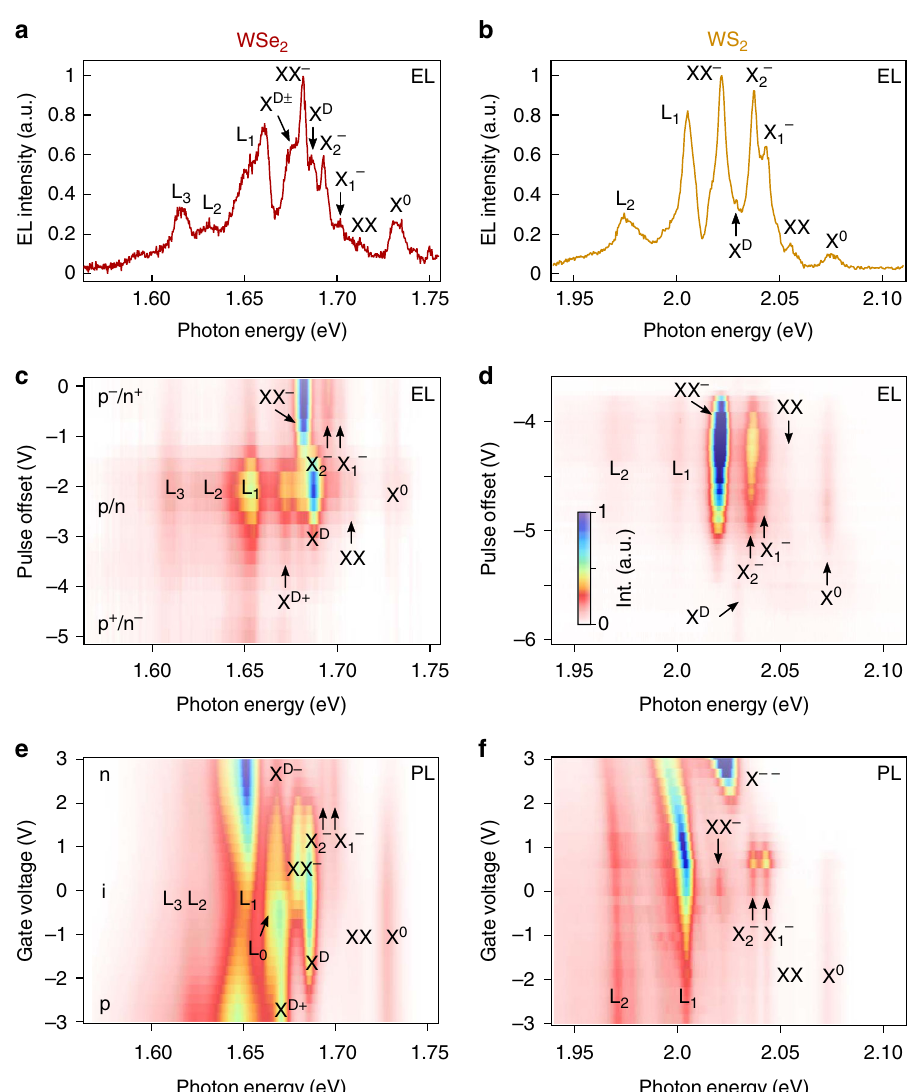
Fig. 2 Emission spectra and tunability at T = 5 K. Pulsed EL from a WSe 2 and b WS 2 . In WSe 2 , a narrow emission (linewidth ∼ 2.8 meV FWHM) is found for both the charged biexciton and the dark exciton. Colormap of EL spectra at 5 K plotted as function of pulse offset V 0 in c WSe 2 and d WS 2 ( V p = 7.5 V). Colormap of charged doping control of PL emission in e WSe 2 and f WS 2 , for different exciton species acquired at an excitation of P d = 5 × 10 3 Wcm − 2